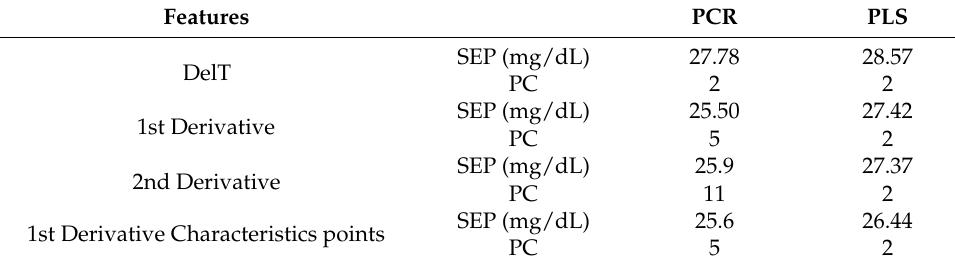
Table 6. Subject wise glucose level prediction error using PCR and PLS models.